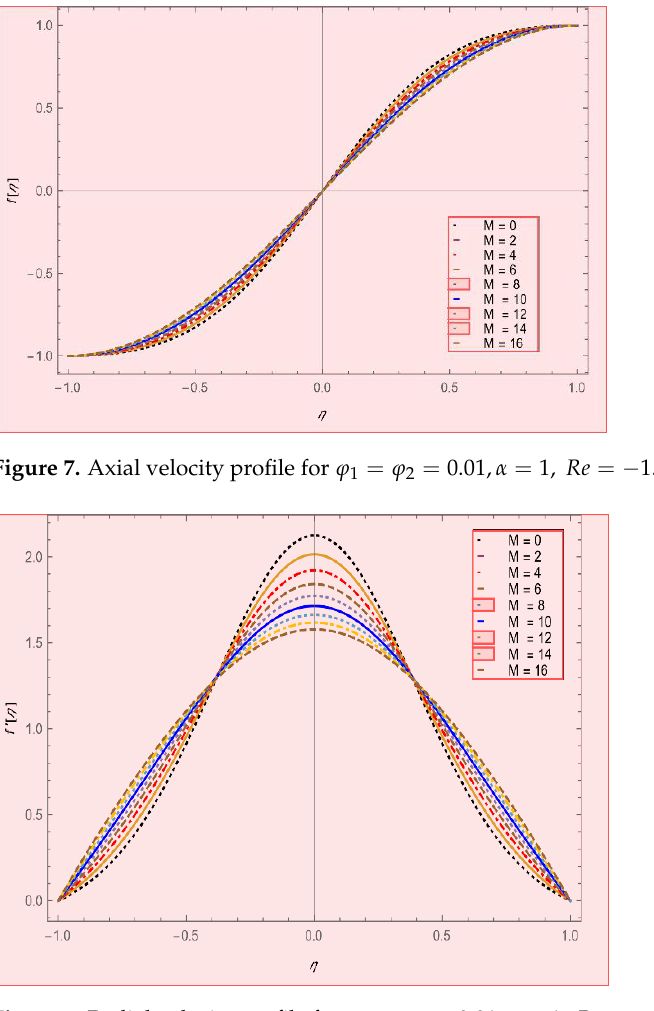
Figure 6. Temperature profiles for volume fraction α = 4, M = 1, Re = − 1, Pr = 6.2.